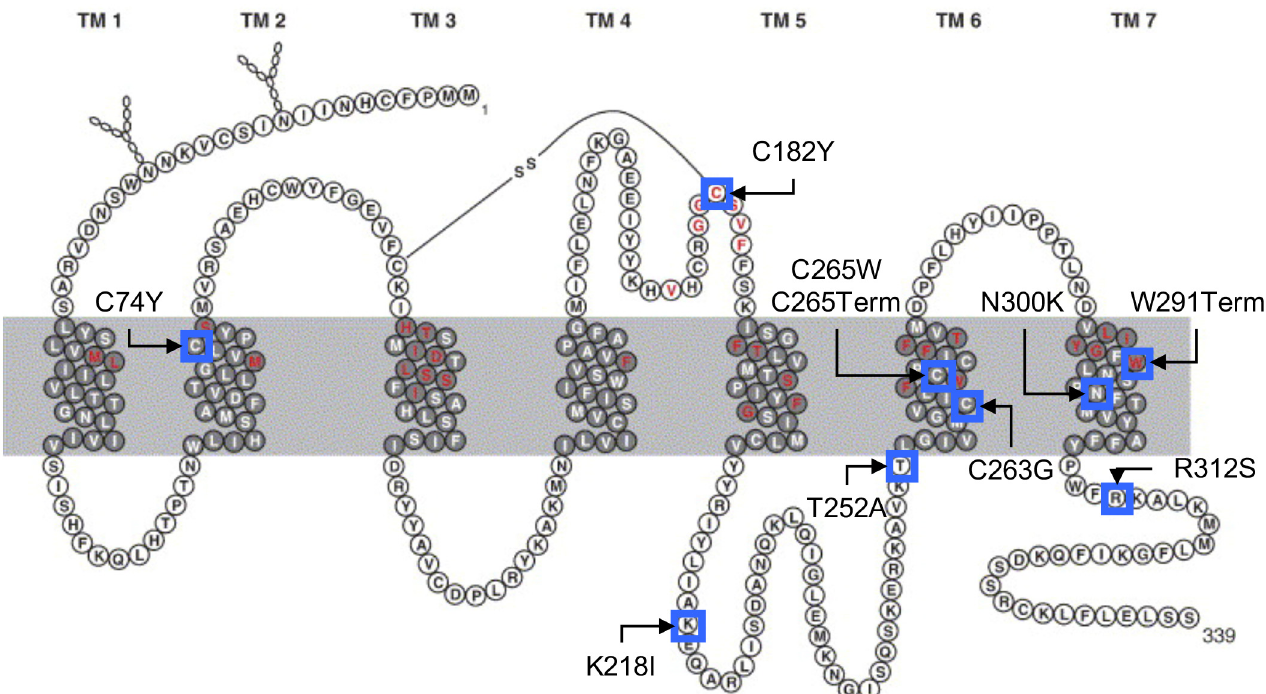
Fig 3. Schematic transmembrane topology of hTAAR 1. (Adapted from [35].) Amino acid residues incorporated in the transmembrane domains are shaded in gray, residues putatively involved in ligand binding are colored red. N-linked glycosylation at N 10 and N 17, as well as the disulfide bridge linking C 96 and C 182, is indicated according to the annotation in Swiss Prot entry TAR1_HUMAN. Known non-synonymous SNPs in the hTAAR1 that may produce changes in receptor function are boxed in blue (as determined from NCBI SNP Database). Indicated is the amino acid change induced by the SNP as: reference amino acid, residue number, change amino acid (Term = Termination). Further details, including the SNP nucleotide change are provided in the text.